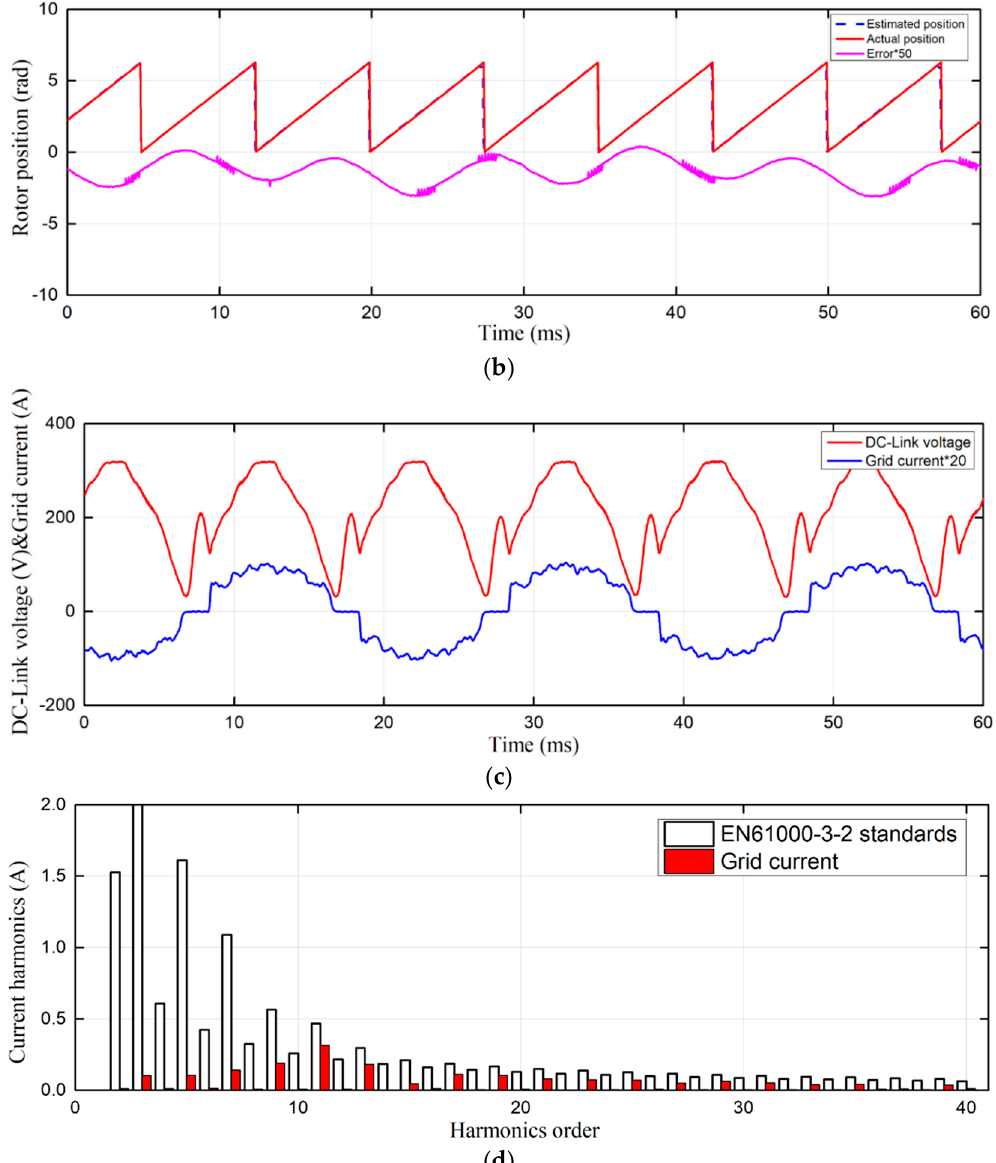
Figure 22. Experimental result of the FSMO estimate method with a PIR controller: ( a ) Motor Speed; ( b ) Position and estimated error; ( c ) DC-link voltage and grid current; ( d ) FFT analysis of grid current.